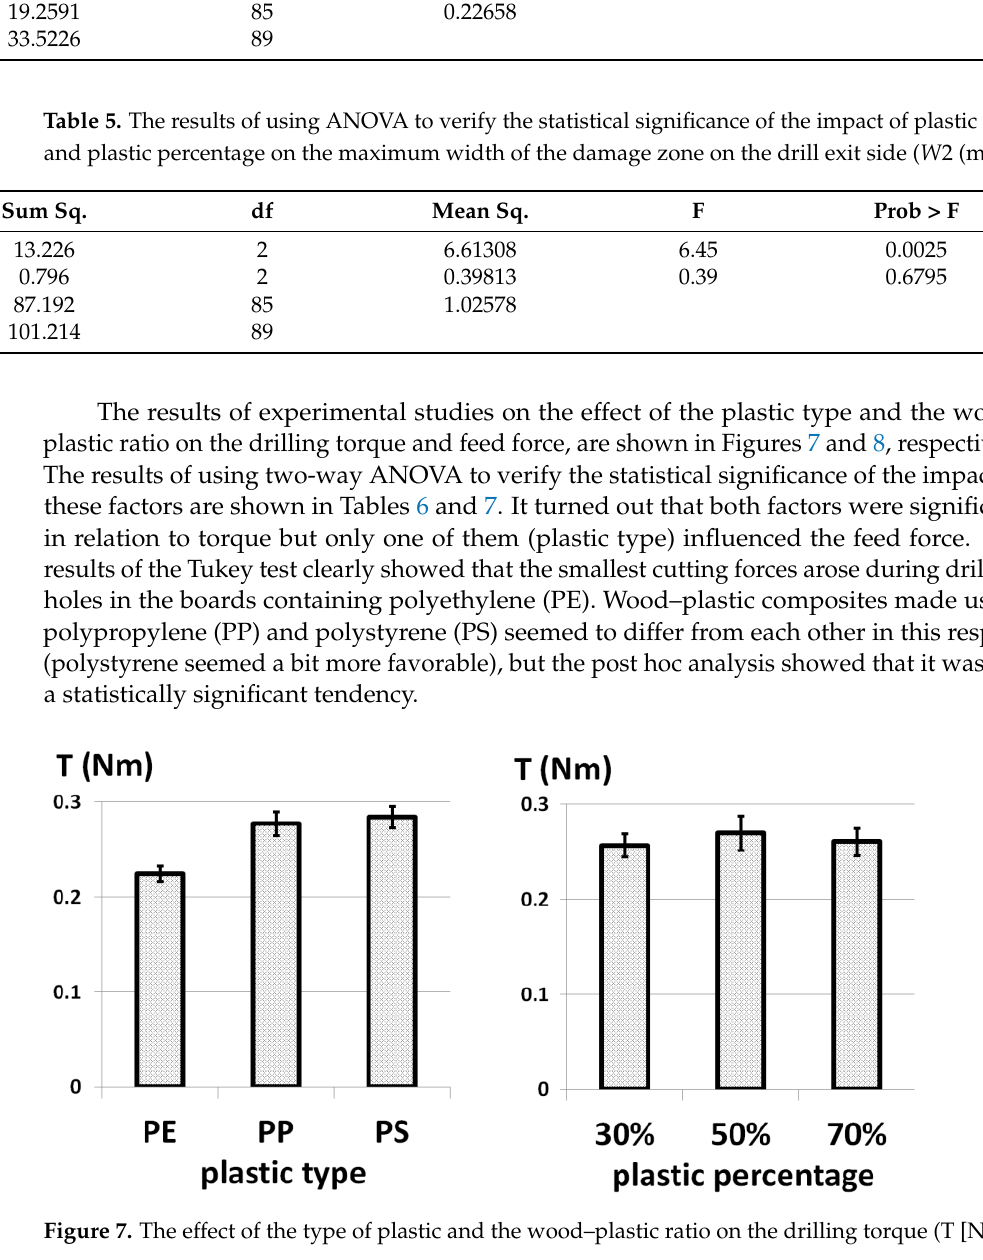
Figure 7. The effect of the type of plastic and the wood – plastic ratio on the drilling torque (T [Nm]).